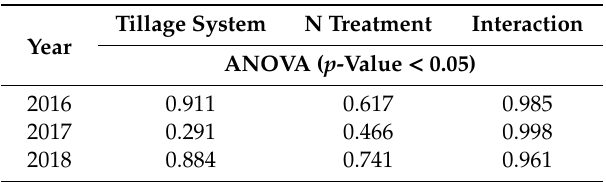
Table 3. Analysis of variance results for tillage system, nitrogen (N) treatment, and interaction e ff ects on agronomic use e ffi ciency of N by the cotton crop in 2016, 2017, 2018.